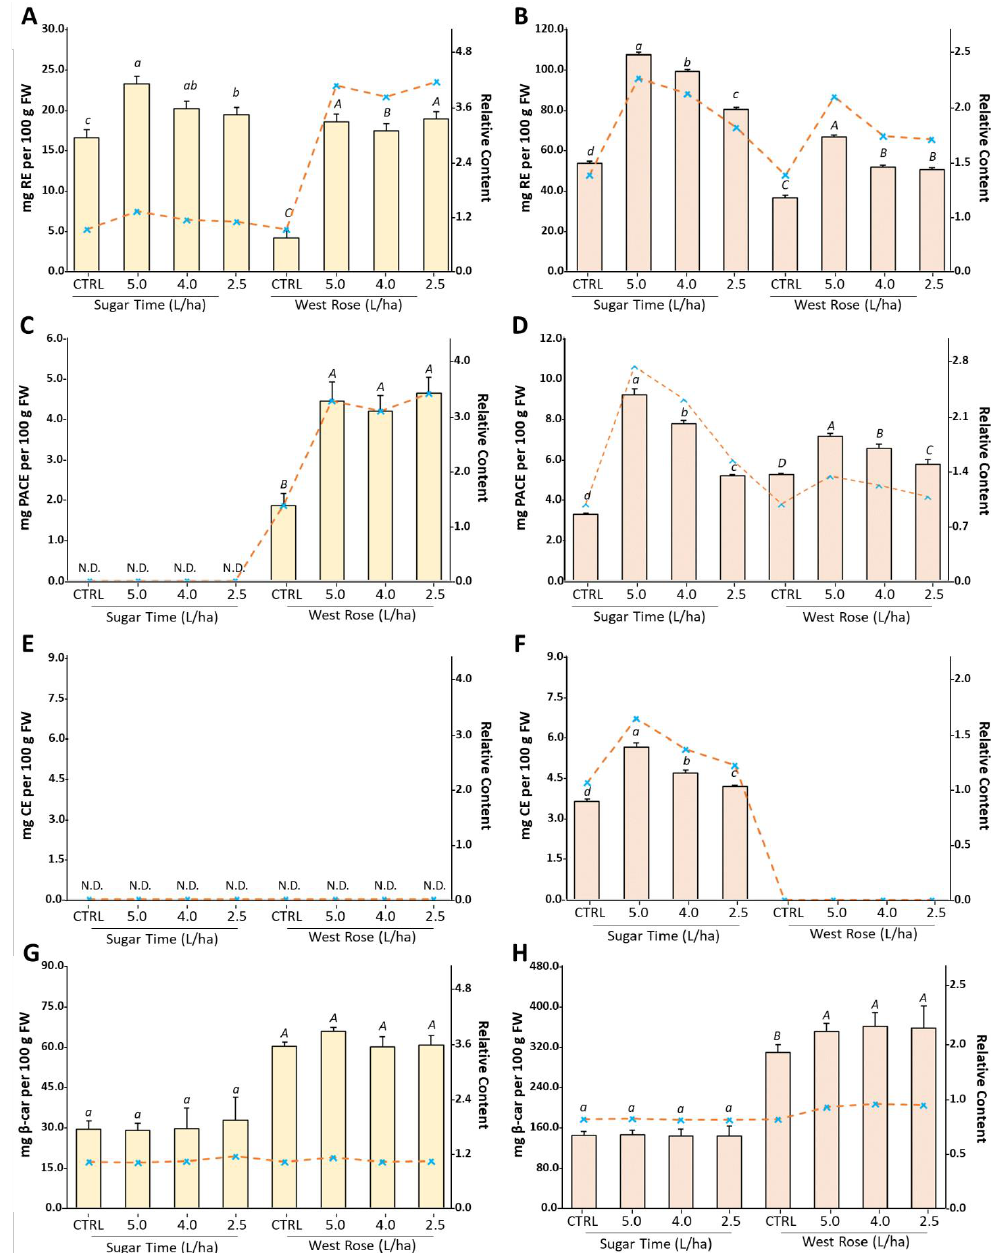
Figure 3. Total content of flavonoids ( A , B ), flavan-3-ols ( C , D ), anthocyanins ( E , F ) and carotenoids ( G , H ) measured in the pulp ( A , C , E , F ) or peel ( B , D , F , H ) of peaches harvested from trees treated with different dosages of biostimulant (5.0, 4.0 or 2.5 L/ha) or with water alone. In the different panels, CTRL identifies samples harvested from trees treated with water only. Values are represented as the mean ± SD. For each panel, within the same variety ( “ Sugar Time ” or “ West Rose ” ) the different lowercase (var. SugarTime) or uppercase (var. West Rose) letters indicate significant differences at p ≤ 0.05, as measured by Tukey’s multiple interval test. The letter “ a ” indicates the highest value. For instance, Rahman et al. demonstrated that the application of probiotic bacteria as a biostimulant significantly increased the TPC and TFC in treated strawberries [55]. Even Garcia-Seco et al. reported that the application of a microbial biostimulant enhanced the flavonoid metabolism in blackberries [56]. Instead, Nagy et al., investigating the effect derived from the application of four different algal products on apple trees, highlighted that only one of the tested formulations was able to positively affect the TFC